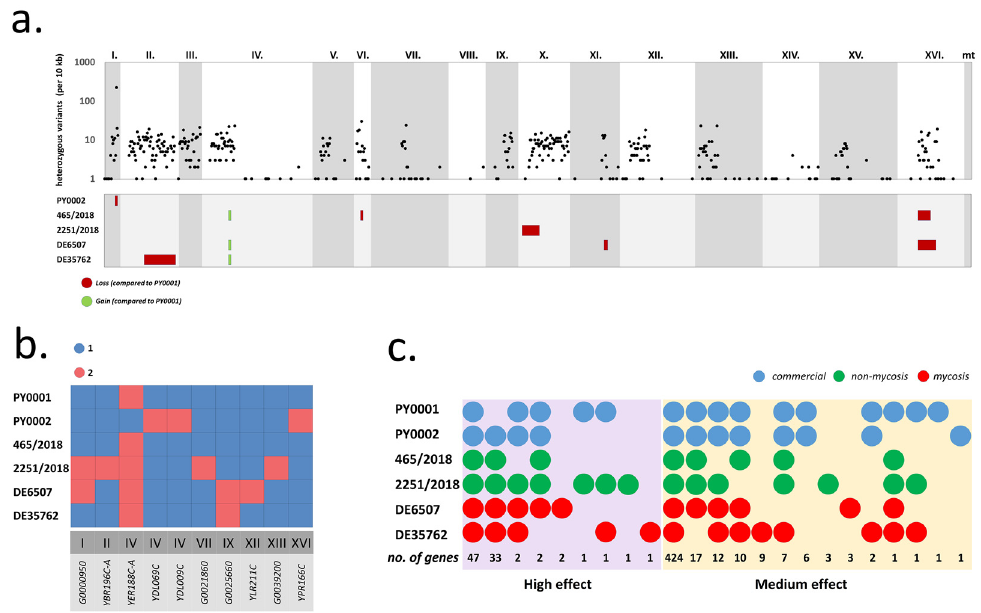
Figure 2. Genomic comparison of the yeast isolates used for the deletion of HMX1 . ( a ) Heterozygous variant density (per 10 kb) across chromosomes for the isolate PY0001 (top) and changes in allele ratios, i.e., gains and losses of heterozygous regions in the other five isolates (bottom). ( b ) Gene copy number variations in the six sequenced isolates. ( c ) The distribution of protein-coding genes affected by high- and medium-effect mutations. The total number of affected genes for combinations of isolates are shown at the bottom, each genome is represented by a circle colored according to isolate type (commercial, non-mycosis, mycosis).